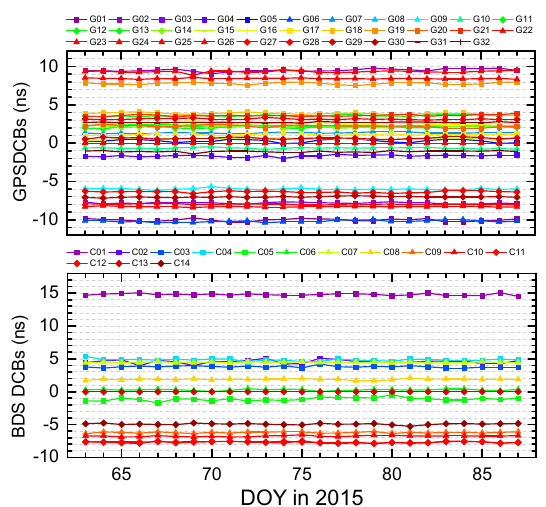
Figure 3. The FY3C-based GPS and BDS daily estimated DCBs during March 2015: ( Top ) GPS daily DCBs; and ( Bottom ) BDS daily DCBs. These values are obtained using the L4-cor strategy. Different colors represent for different satellites.